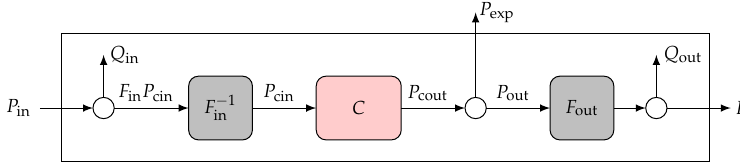
Figure 2. Illustration of the structure of the Energy Hub